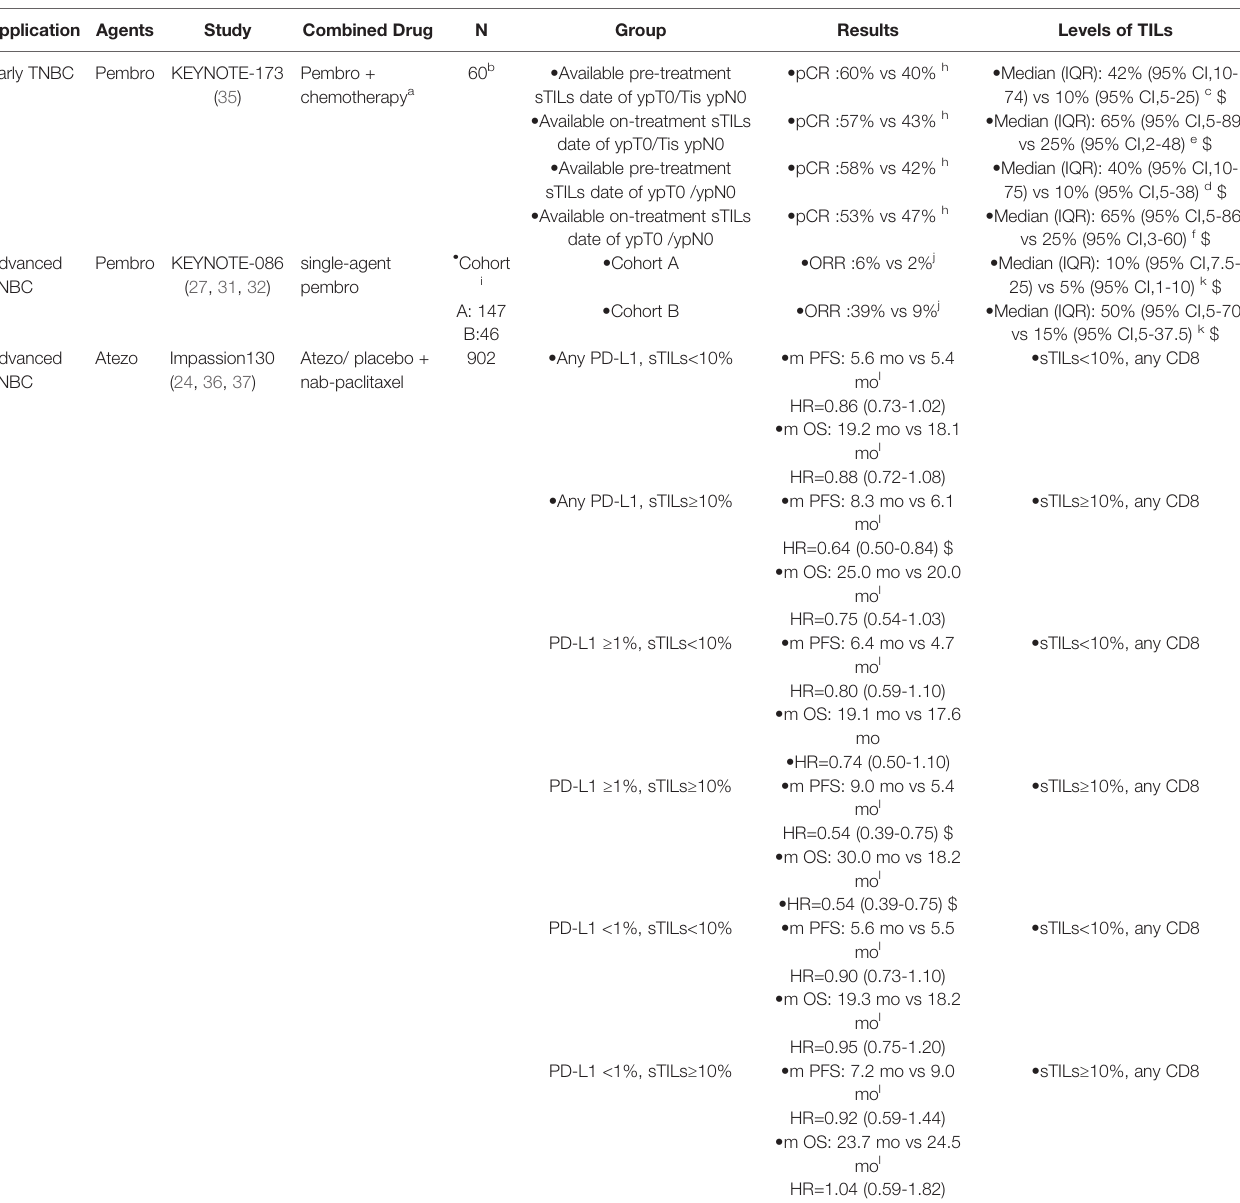
TABLE 3 | Results of the exploratory studies of TILs in TNBC patients treated with PD-1/PD-L1